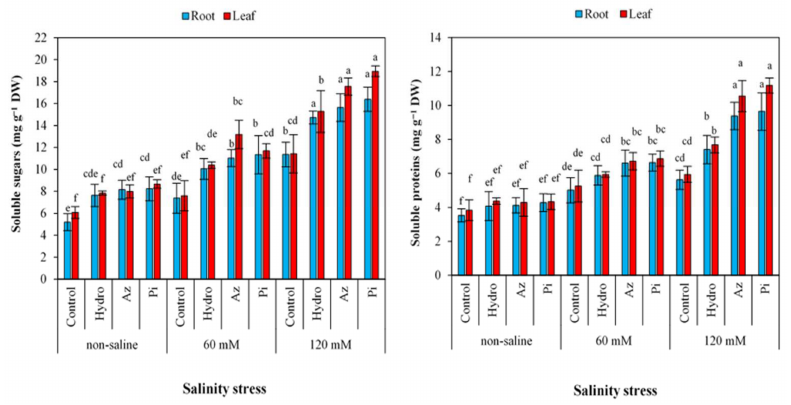
Figure 6. Effect of seed priming on soluble sugar and proteins in root and leaves of milk thistle under different salinity levels. The same letter within each column indicates no significant difference among treatments ( p ≤ 0.05) using New Duncan’s test. Values mean of four replicates ± SD. Hydro: hydro-priming, Az: Azotobacter chroococcum and Pi: Piriformospora indica